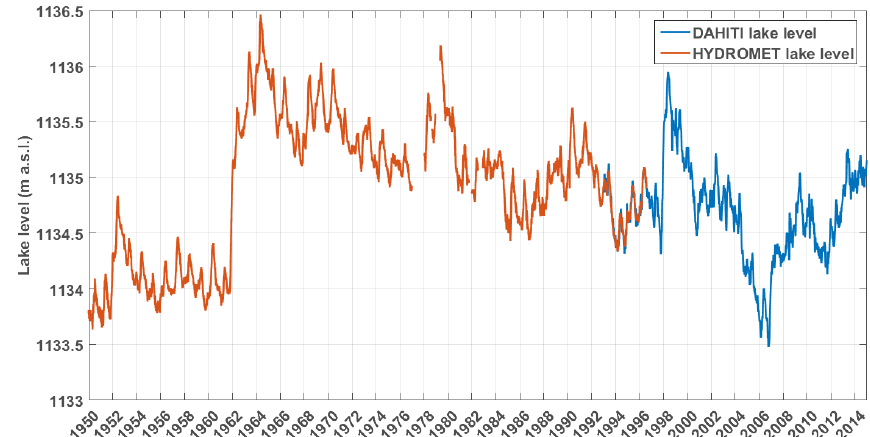
Figure 2. Lake Victoria historical water levels: HYDROMET: in situ measurements from the World Meteorological Organization (WMO) hydrometeorological survey from 1950 to 1996 with data gaps in 1977, 1978, 1979, 1981 and 1982 (WMO, 1981), converted from measured lake depth at Jinja, to meters above sea level using the EIGEN-6c3stat geoid model. DAHITI satellite altimetry measurements from 1992 to 2014 (Schwatke et al.,